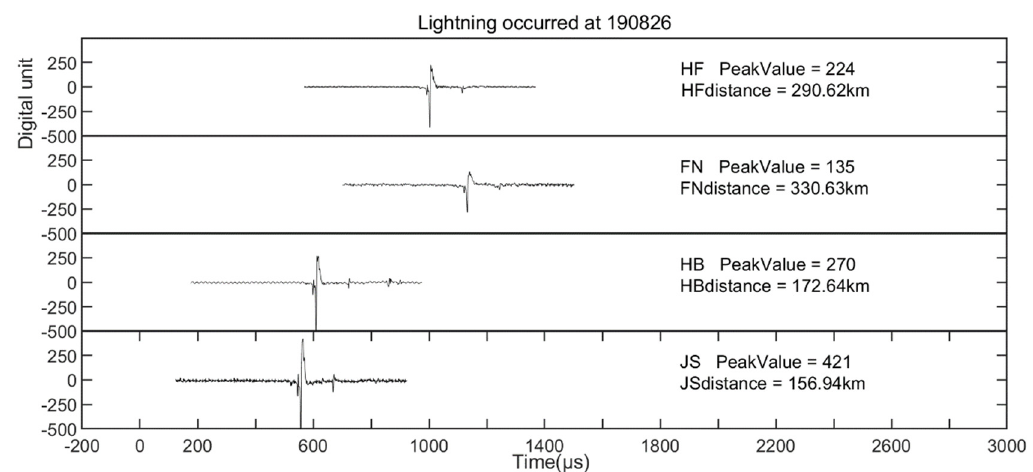
Figure 5. Waveforms of the same IC lightning stroke measured by stations of the Jianghuai Area Sferic Array.